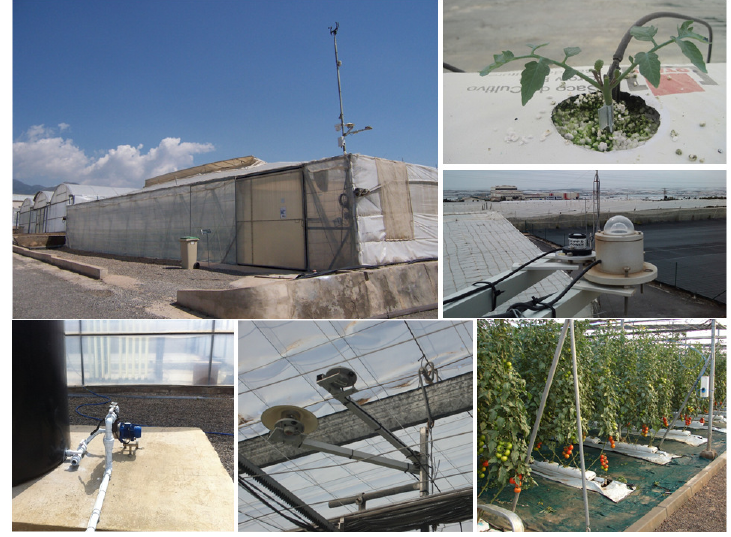
Figure 3. Greenhouse facilities used for the experiments performed in this work. From left to right and from top to bottom: greenhouse, dropper, solar and PAR radiation device at the outside, irrigation system, solar and PAR radiation device inside the greenhouse and the tomato crop